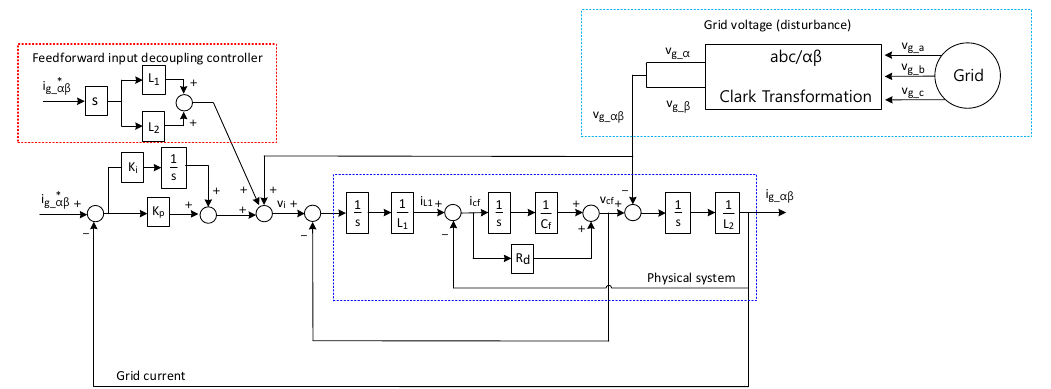
Figure 2. Block diagram of a GCI current control system with command feedforward control (CFFC).